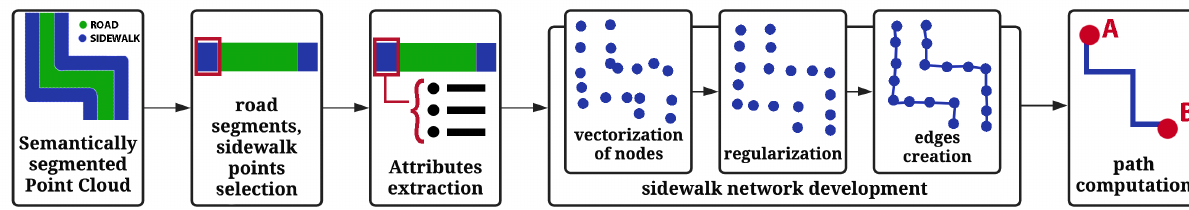
Figure 1. Workflow of the method. Starting from an urban environment semantically segmented point cloud, sidewalk points were extracted and used to compute accessibility attributes, and then are converted to a vector layer with nodes and edges to be used for path